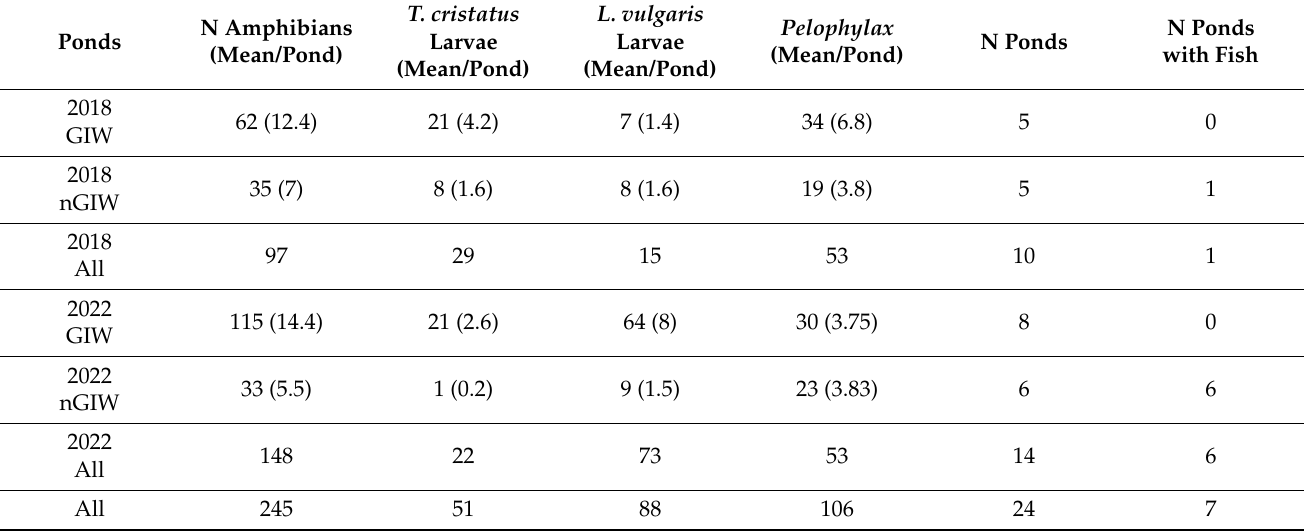
Table 2. The numbers of individuals and the average number of individuals of newts and frogs Pelophylax identified in Silene Nature Park, South East of Latvia, during the monitoring periods 2018 and 2022 (method 2.2.1, using a net—the number of individuals per 10 net sweeps per pond, and method 2.2.2—the number of individuals of Pelophylax per 10 m 2 , mean/pond) in isolated wetlands GIW and non-isolated ponds nGIW